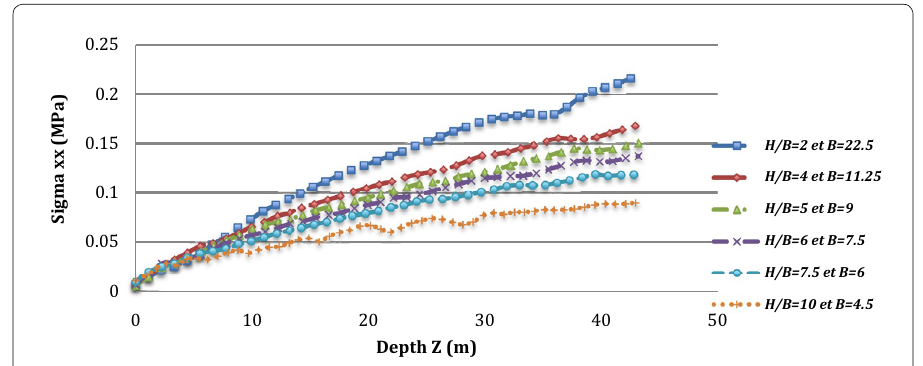
Fig. 12 Comparison of horizontal stress estimates from numerical models having variable H/B ratios, H 45 =